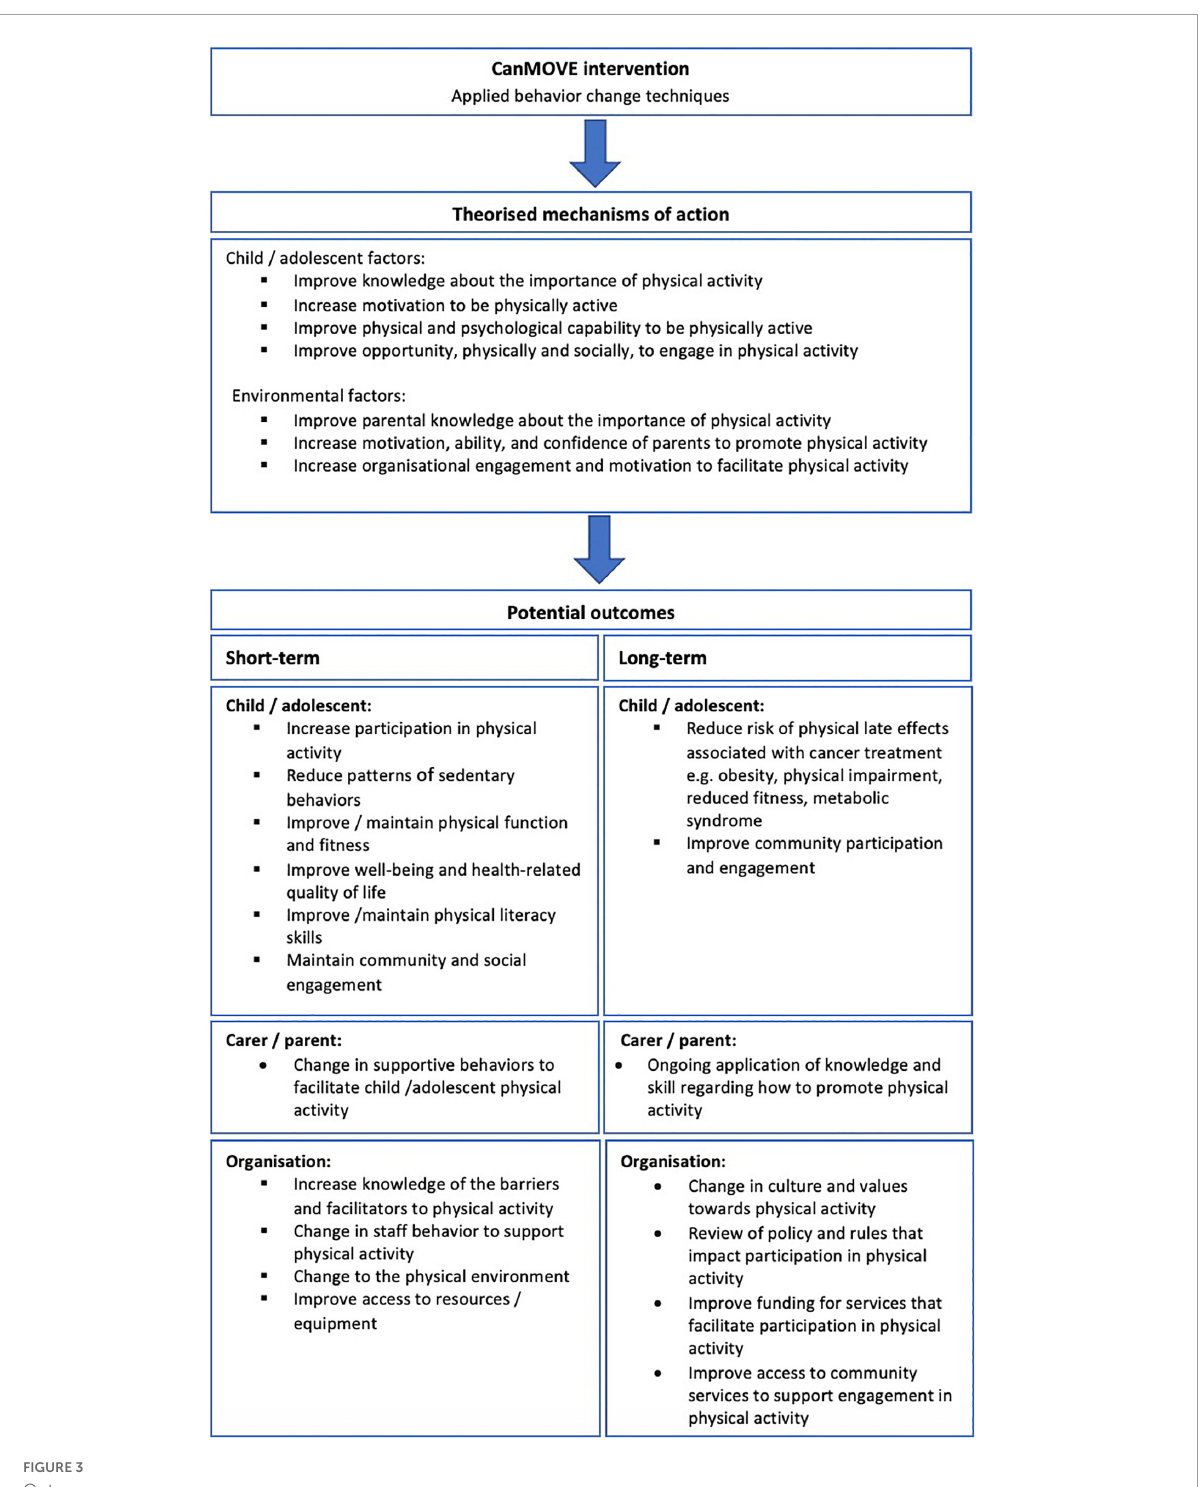
FIGURE3 Outcomes.